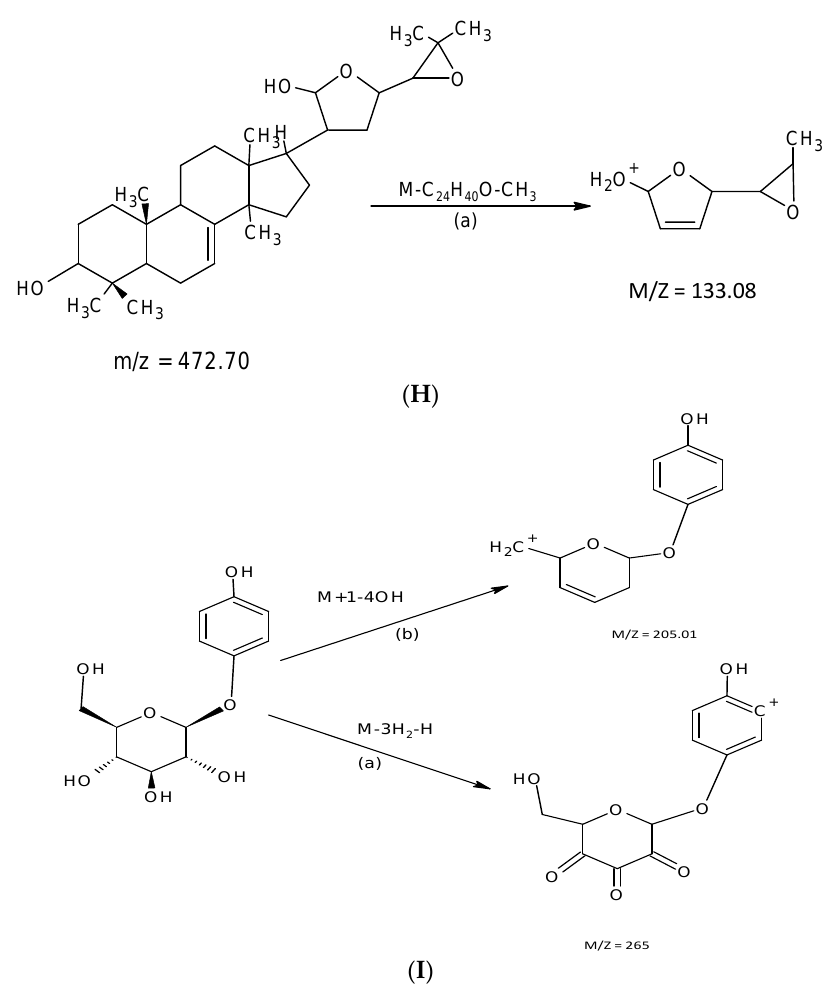
Figure 6. Mass fragmentation mechanisms of ( A ) zeaxanthin, ( B ) leucodelphinidin, ( C ) azedarachin C, ( D ) 3- O -benzyl-2- O -deoxyingenol, ( E ) picrasinoside E, ( F ) schizonepetoside E, ( G ) 1β,3β,6α-trihydroxy-4α(15)-dihydrocostic acid methyl ester-1- O -β- D glucopyranoside, ( H ) melianol, and ( I ) arbutin, as identified in the CILEx. Table 4. Docking scores of 8 PubChem-available compounds out of 10 identified compounds from LCMS data for CILEx. Compounds Docking Score Glide Model Glide Energy